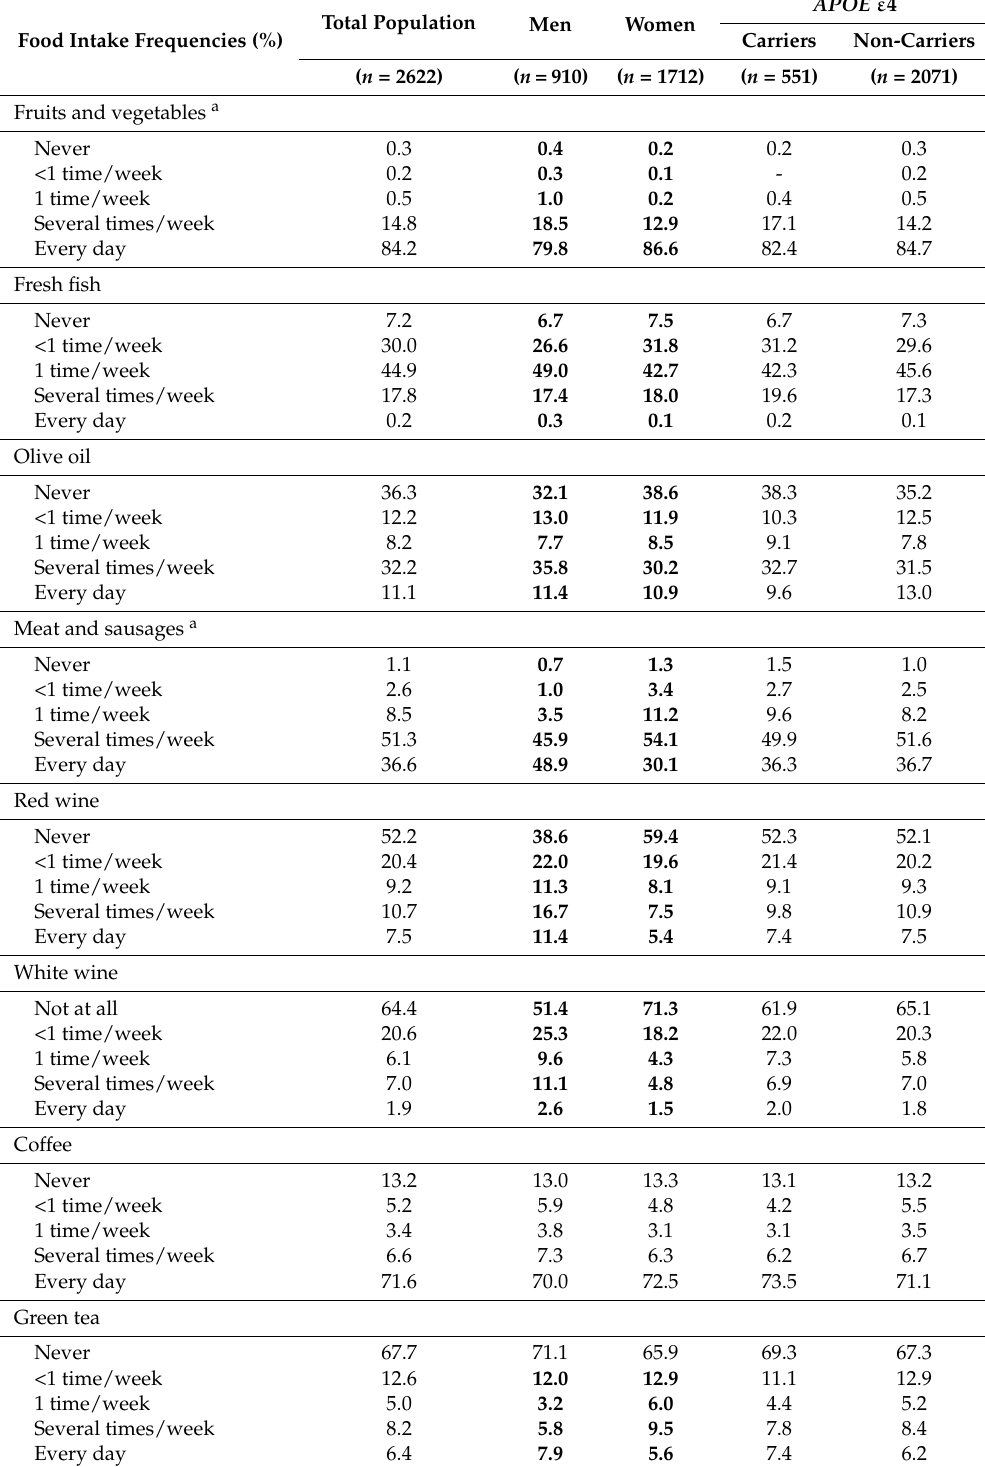
Table 2. Food intake frequencies (%) in participants of the AgeCoDe cohort at follow-up